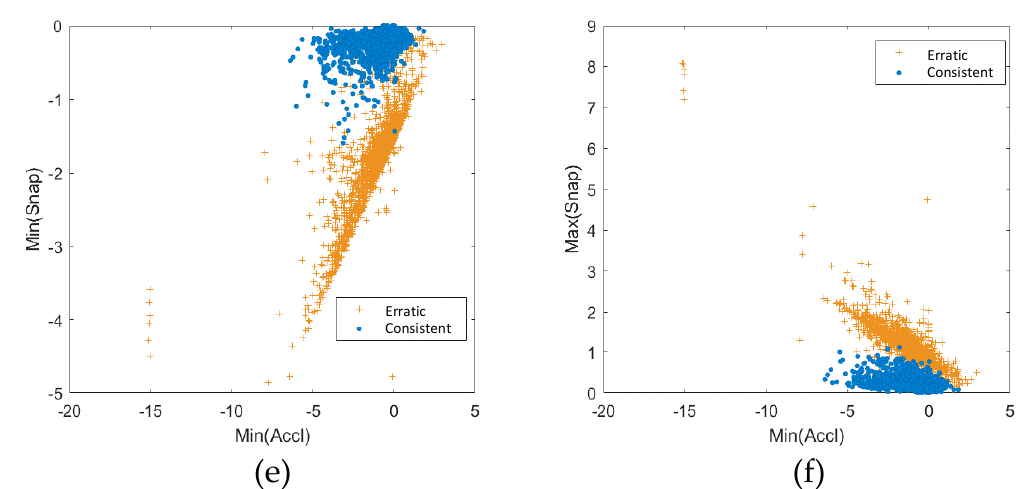
Figure 6. Kinematic behaviors grouping.